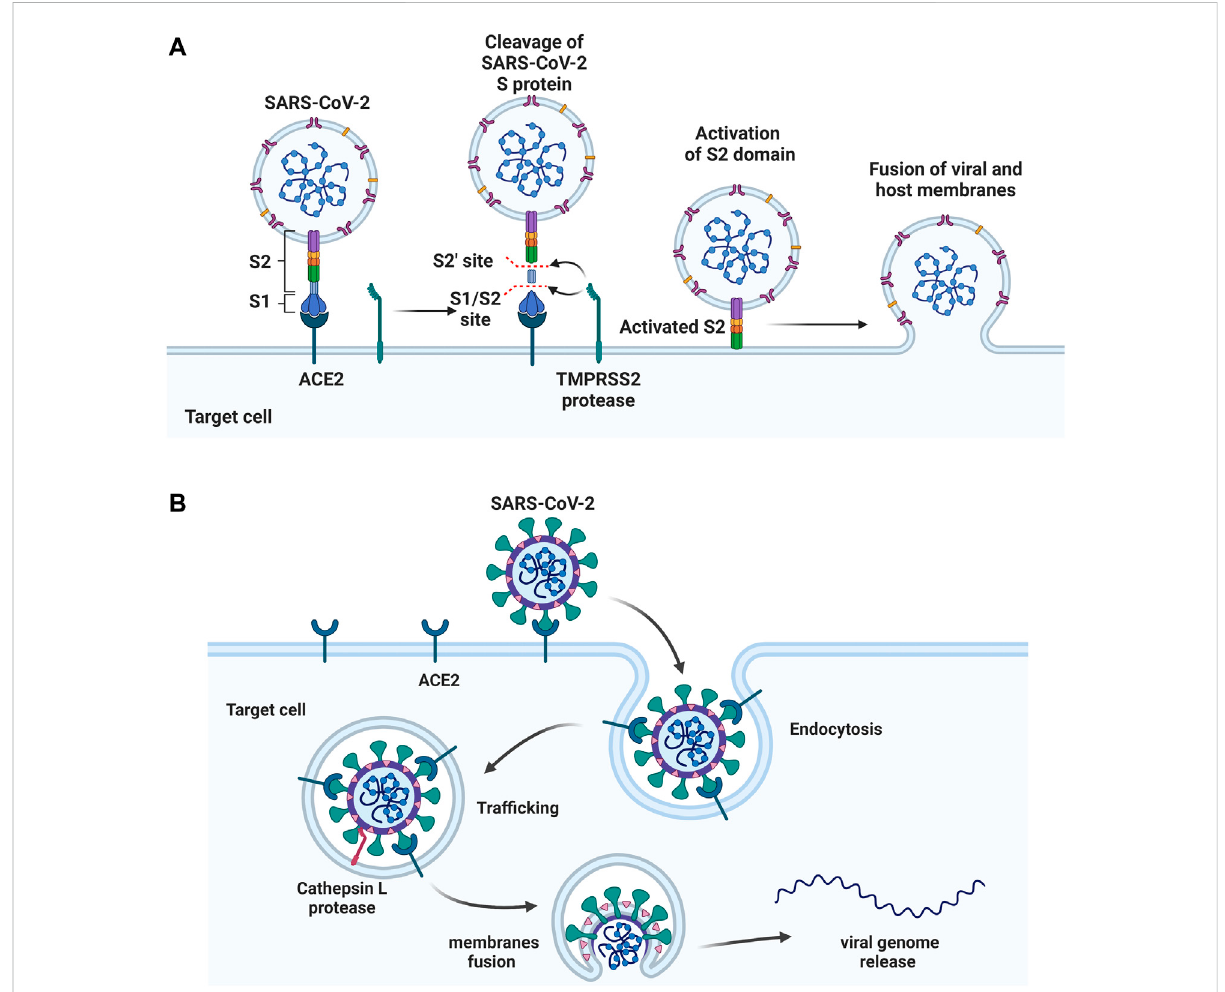
FIGURE 3 Two approaches of SARS-CoV-2 entry. (A) S protein binds to the host ACE2 receptor, followed by cleaving at S1/S2 and S2 ’ sites by TMPRSS2 protease. S2 domain mediates thefusionof viralandhost membranes. (B) The Sproteinbinds to ACE2, followed bythereceptor mediated endocytosis. The viral fusion occurs in cytoplasm after S activation by host protease cathepsin L. Figure was generated by